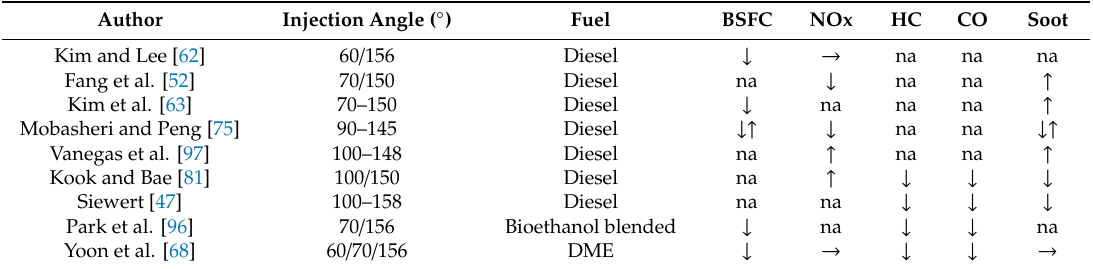
Table 7. Variation of performance and emissions after decreasing the injection angle